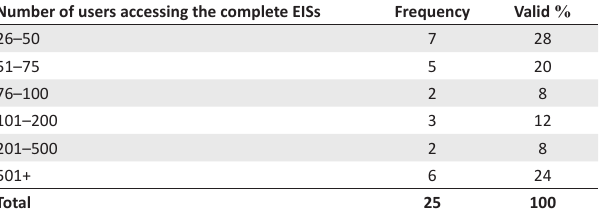
TABLE 4: Number of users accessing the complete Executive Information Systems (EISs).